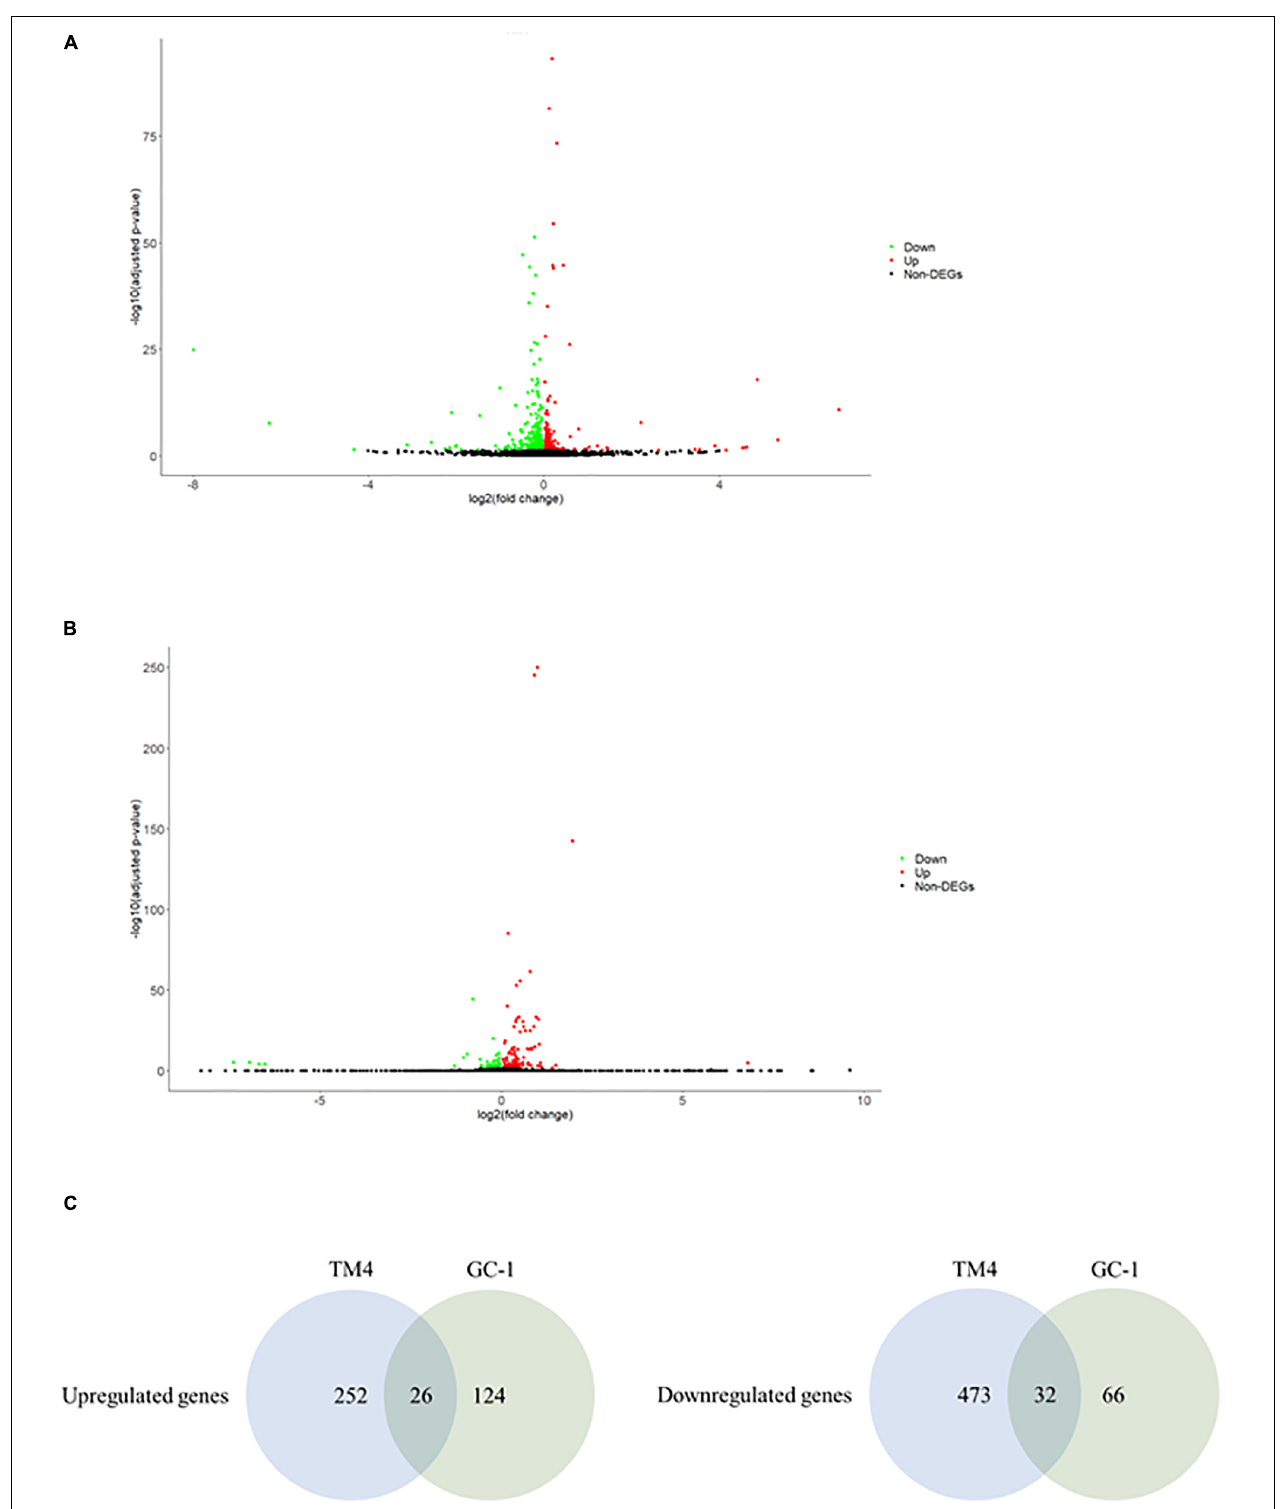
FIGURE 3 | The ionizing radiation exposure caused the differential gene expression in female reproductive cells. (A) Volcano plot showed the differentially expressed genes in the SKOV3 cells. Green dots represented downregulated genes. Red dots represented upregulated genes. (B) Volcano plot showed the differential expressed genes in the COV434 cells. Green dots represented downregulated genes. Red dots represented upregulated genes. (C) Common deregulated genes in SKOV3 and COV434 cells under the ionizing radiation exposure.